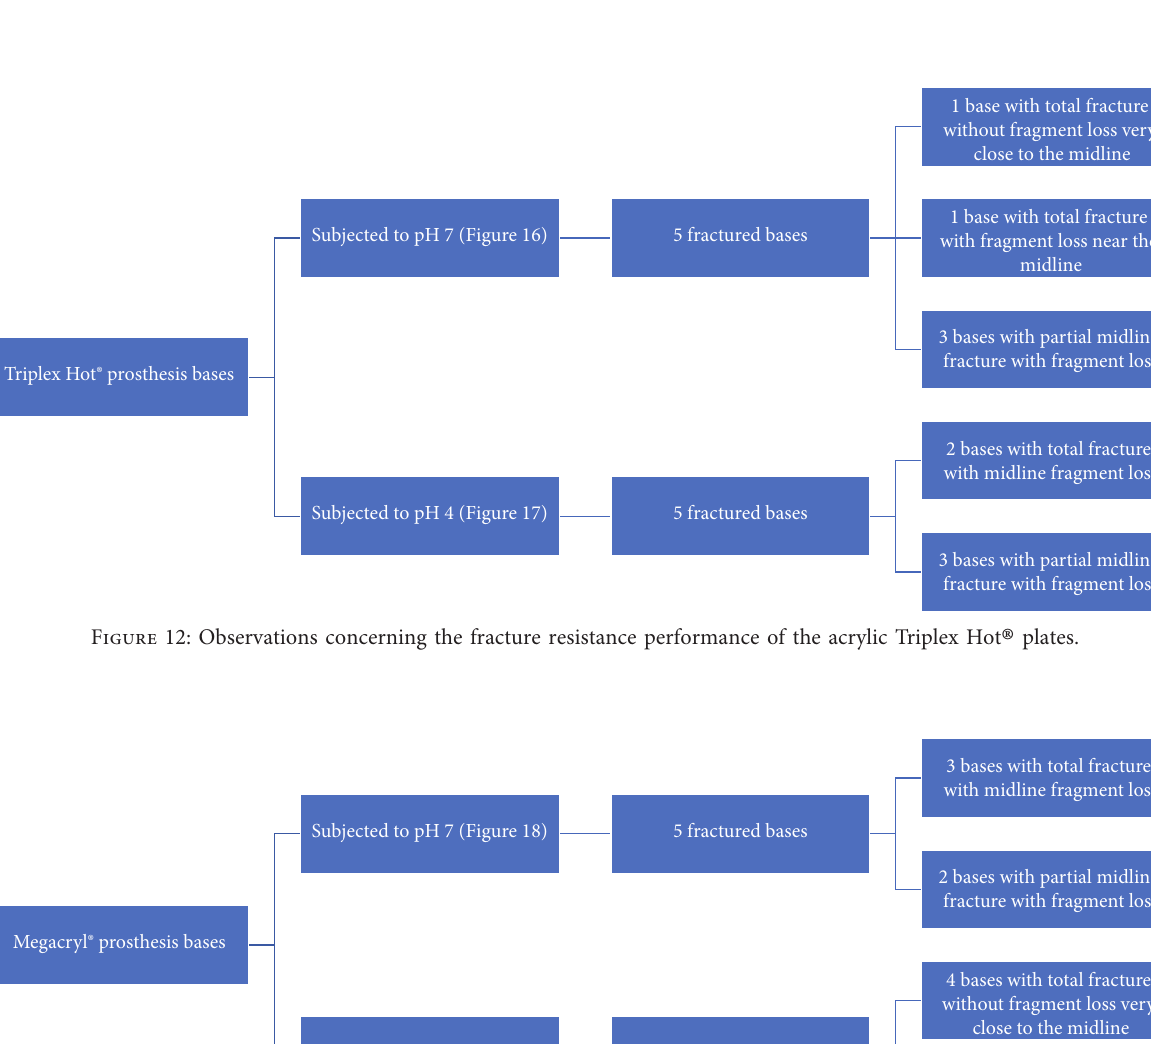
Figure 11: Observations concerning the fracture resistance performance of the acrylic RS Vertex ® plates.